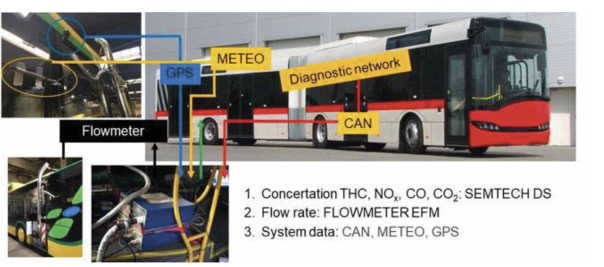
Figure 5: Average road exhaust emissions and average fuel con- sumption of a bus equipped with a spark ignition engine fueled with natural gas